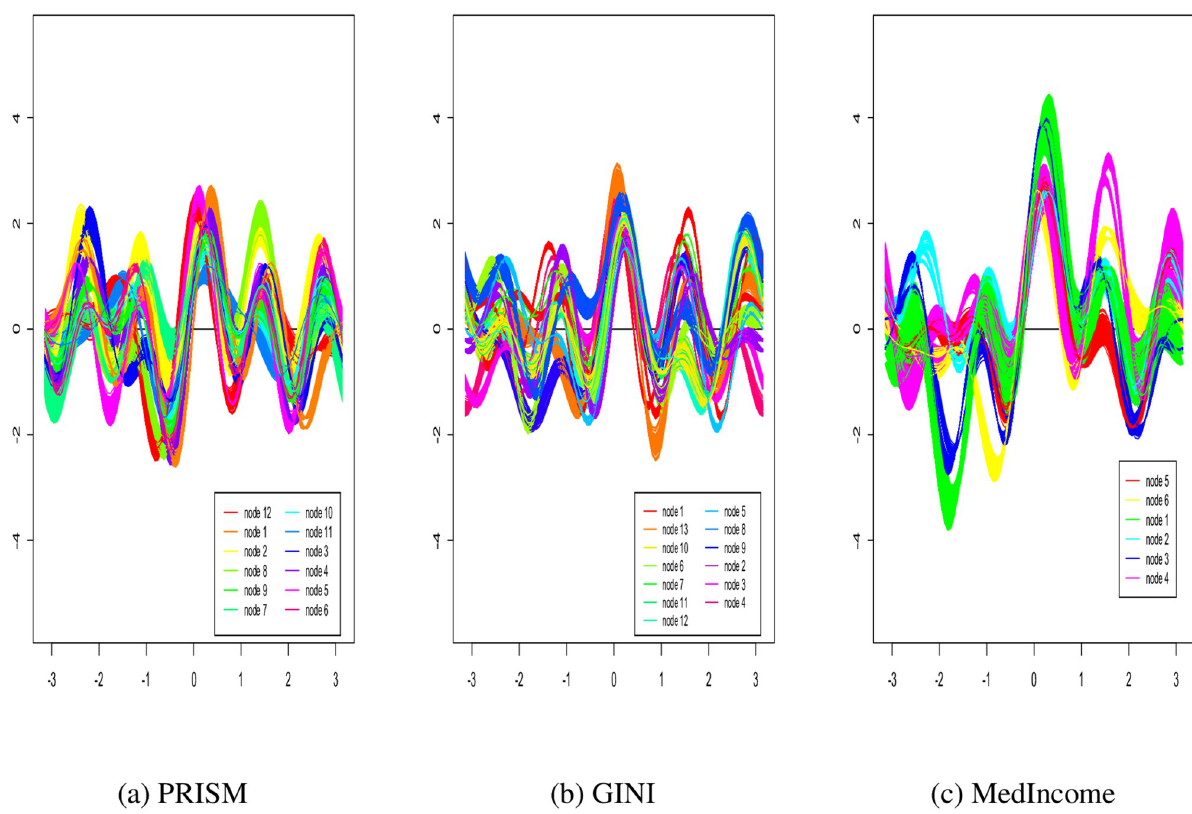
Fig 5. Andrews curves for PRISM and HPRISM models for GINI and MedIncome respectively. (a) PRISM. (b) GINI. (c) MedIncom.